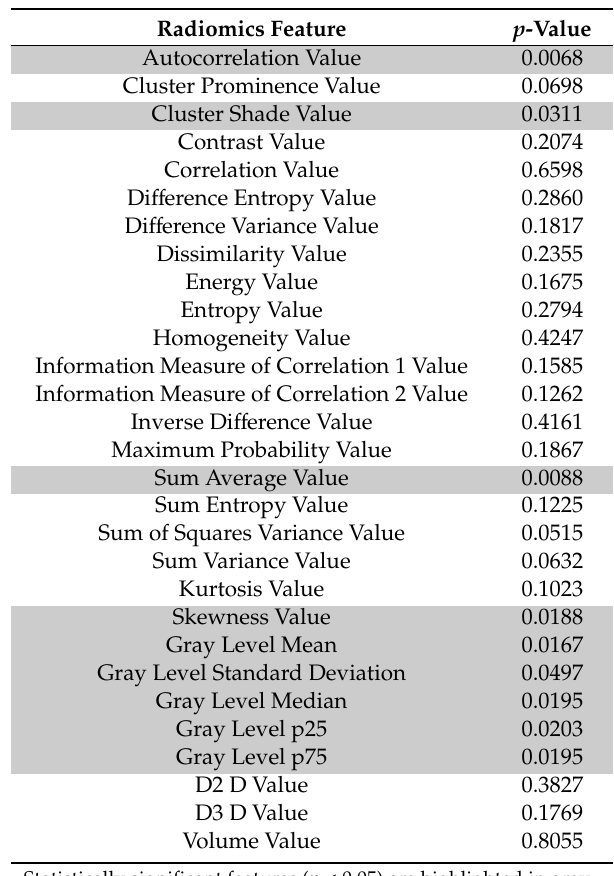
Table 1. Values of MR radiomics features of benign versus malignant parotid